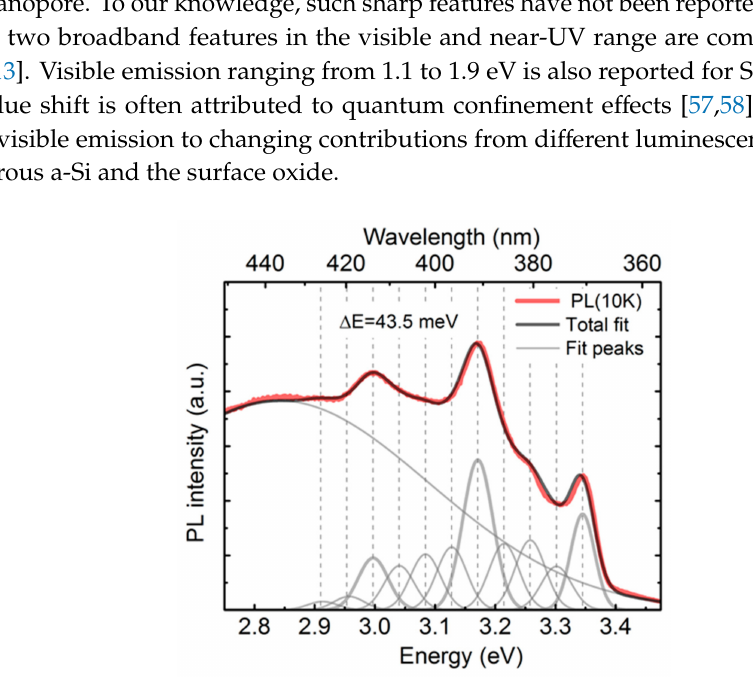
Figure 8. PL spectrum of nanoporous a-Si at 10 K presented alongside with the Gaussian deconvolution components. Vertical markers on the plot indicate equidistant spacing of 43.5